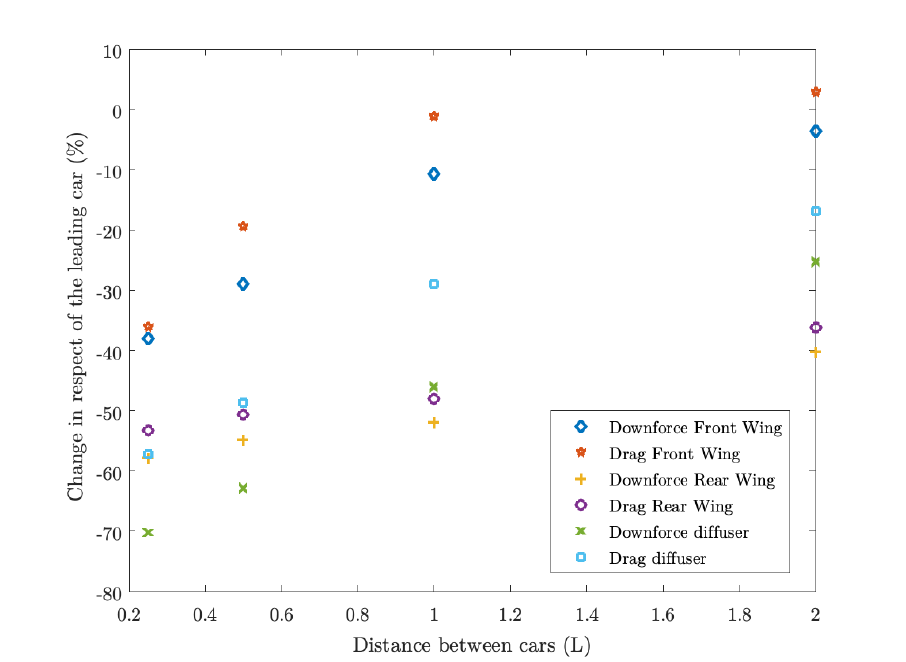
Figure 23. Percentage of change on the performance of the second